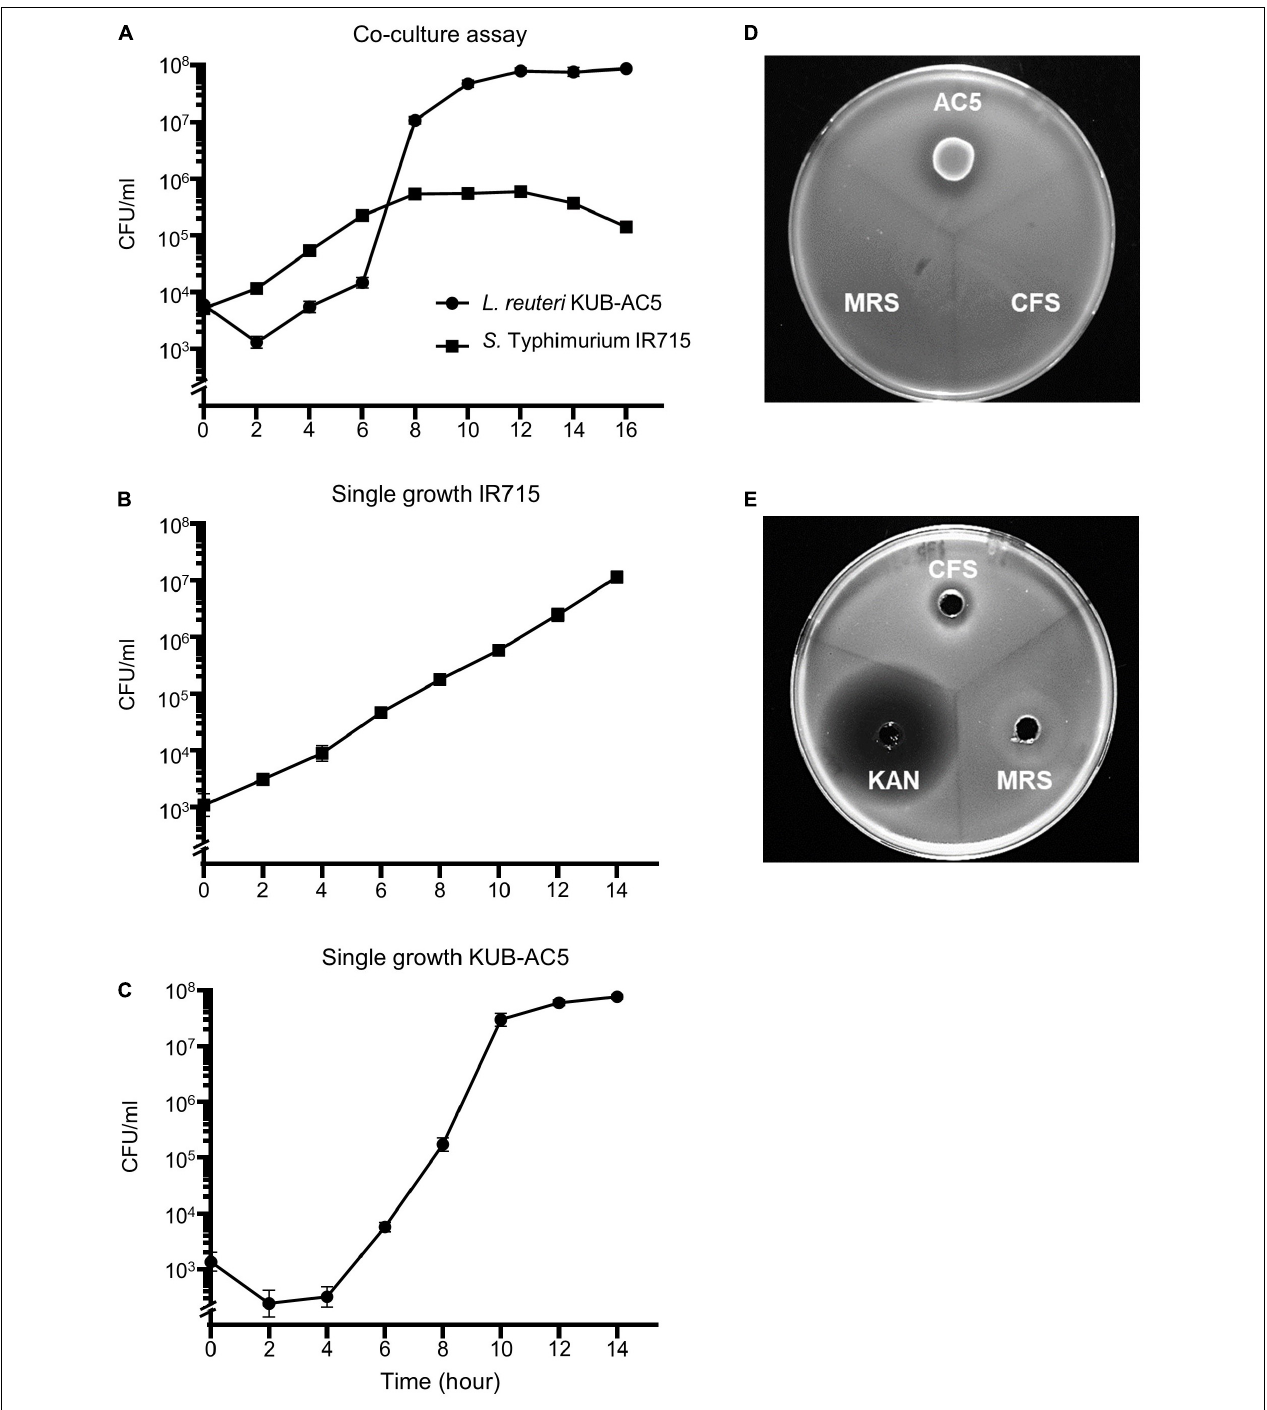
FIGURE 1 | In vitro anti- Salmonella effect of probiotic L. reuteri KUB-AC5 on S. Typhimurium IR715 in liquid and solid media. Co-culture assay was done by inoculating an equal amount of AC5 and STM in de Man, Rogosa, and Sharpe (MRS) and Mueller–Hinton (MH) broth (A) . An independent growth of STM and AC5 in liquid media was performed ( B,C , respectively). The anti- Salmonella activities of AC5 cell-free supernatant (CFS) were tested using spot-on lawn assay (D) and agar well diffusion assay (E) . Data represent geometric means ± SD of three independent experiments. KAN, kanamycin as a positive control, MRS broth as a negative